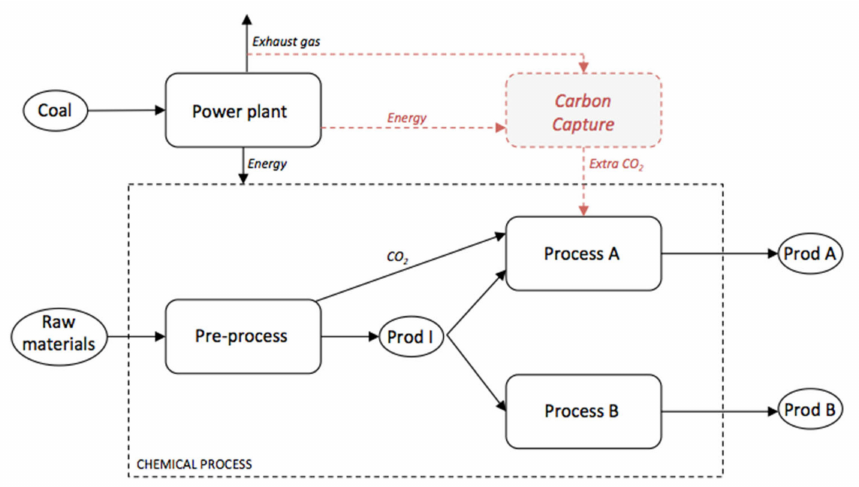
Figure 1. Schematic representation of the considered